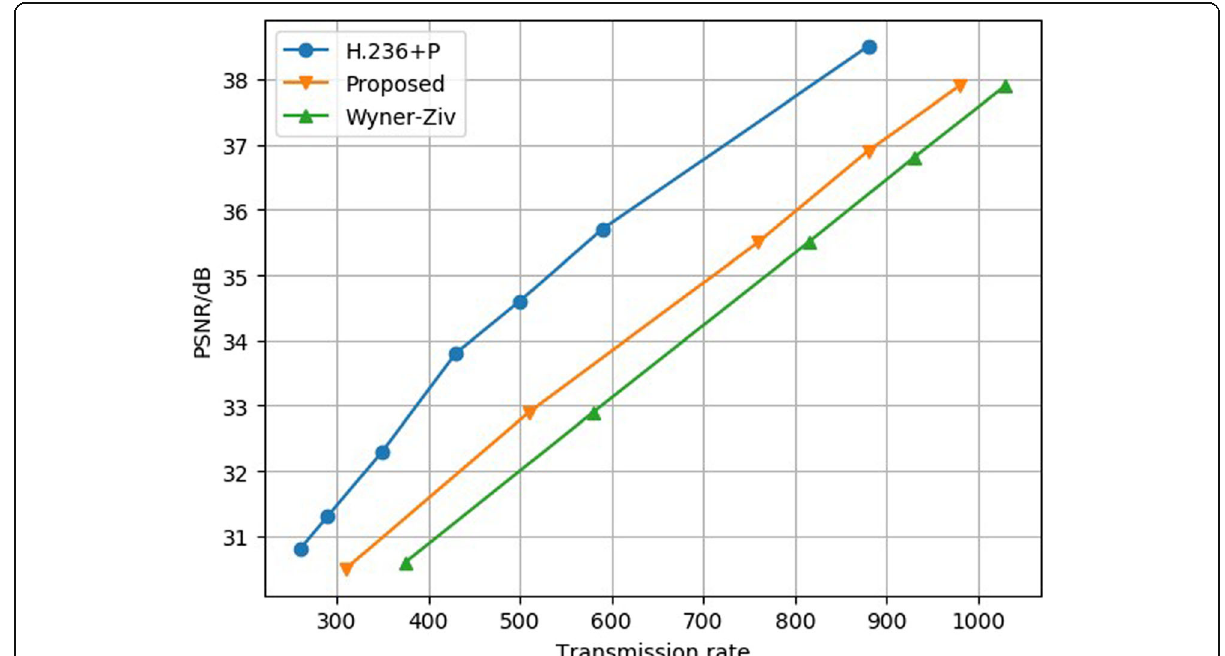
Fig. 1 Comparison of salesman ’ s transmission rate and peak signal to noise